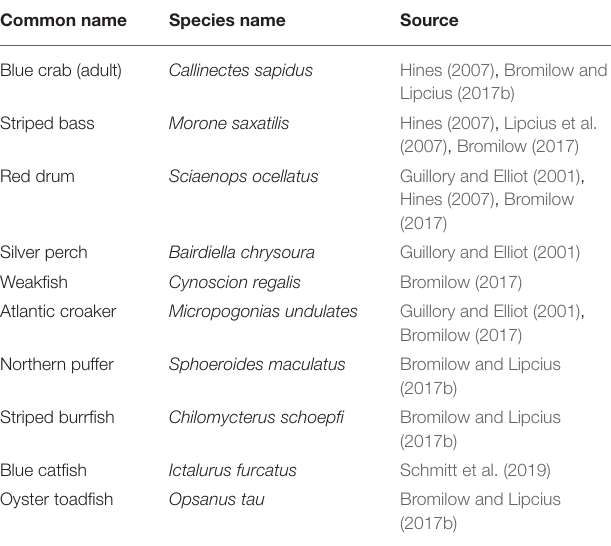
TABLE 2 | List of predator species considered in predation abundance